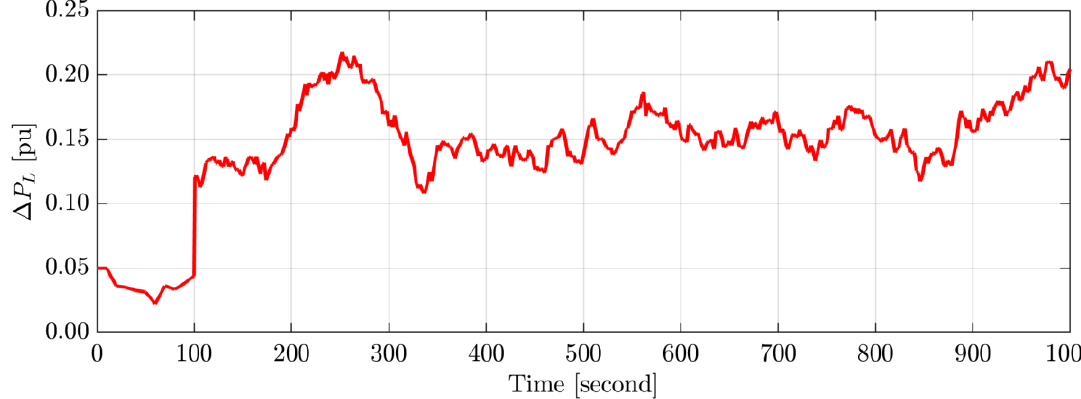
Figure 15. Random load change for the case 3.